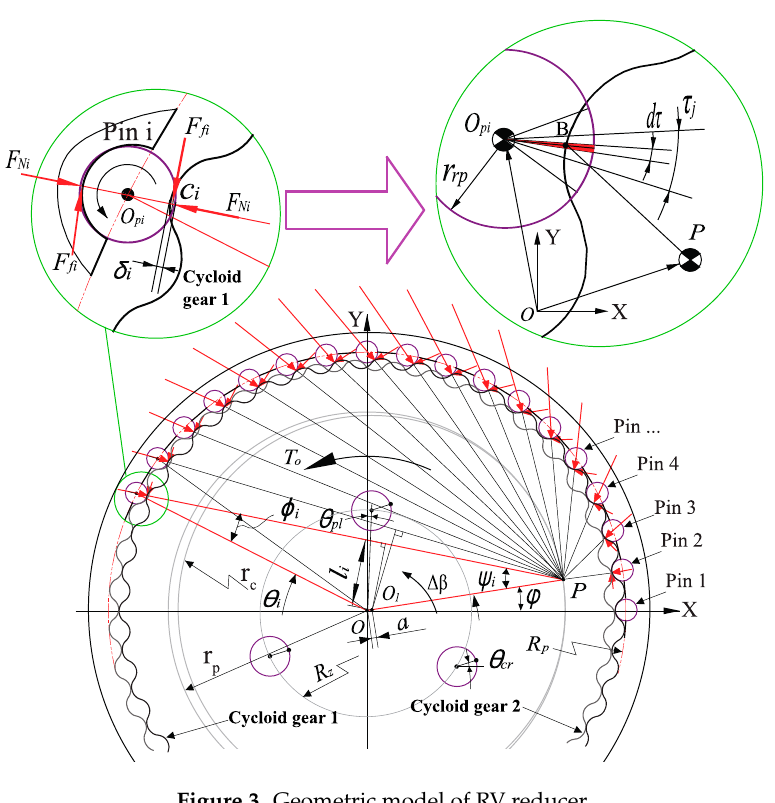
Figure 3. Geometric model of RV reducer.